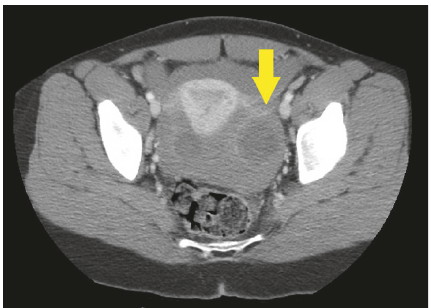
Figure 1: CT of the abdomen with blood surrounding the liver and spleen (arrow).